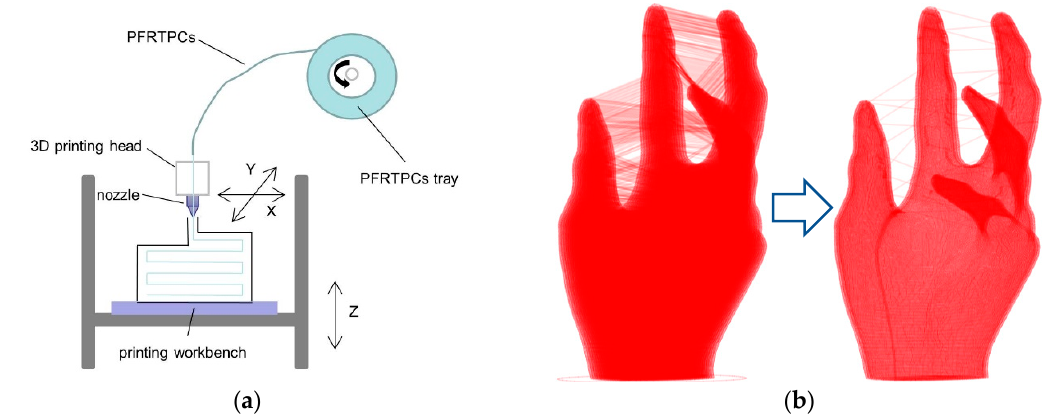
Figure 2. PET fiber-reinforced thermoplastic composites (PFRTPCs) printing schematic diagram. ( a ) Platform diagram. ( b ) From common infill path to a global continuous fill pattern.